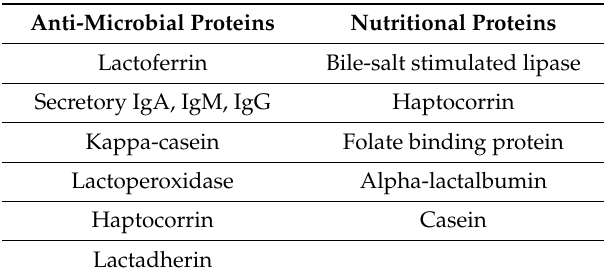
Table 2. Proteins present in maternal